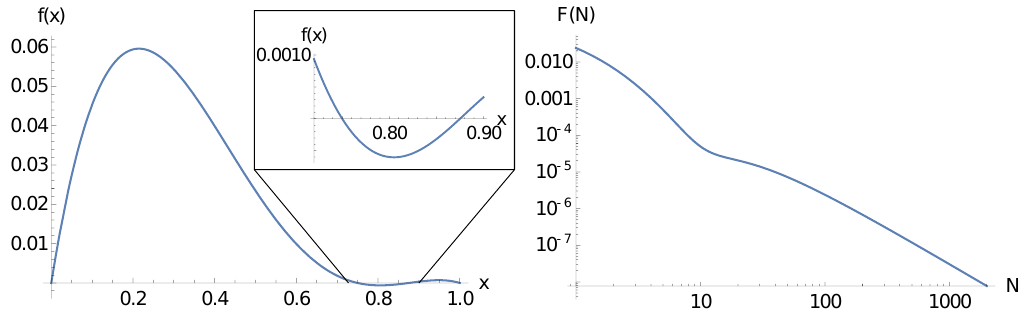
Figure 1: Plotting our example function in x -space (left-hand side) and N -space (right-hand